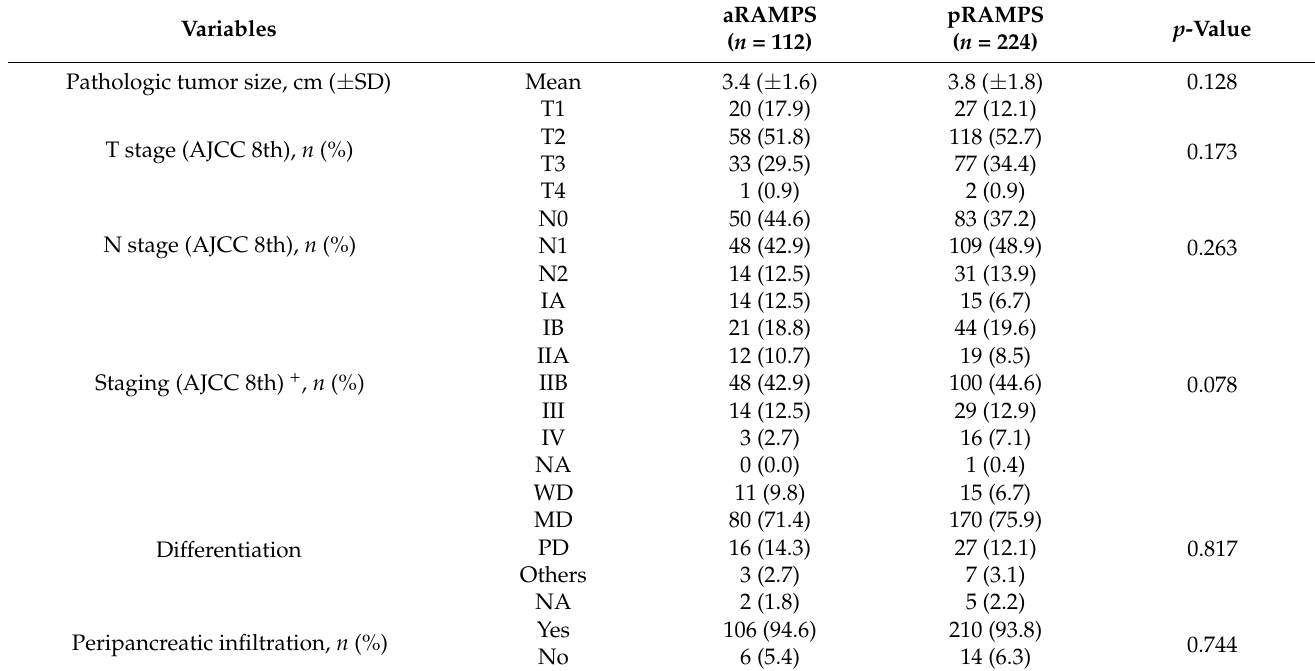
Table 3. Pathologic outcomes of radical antegrade modular